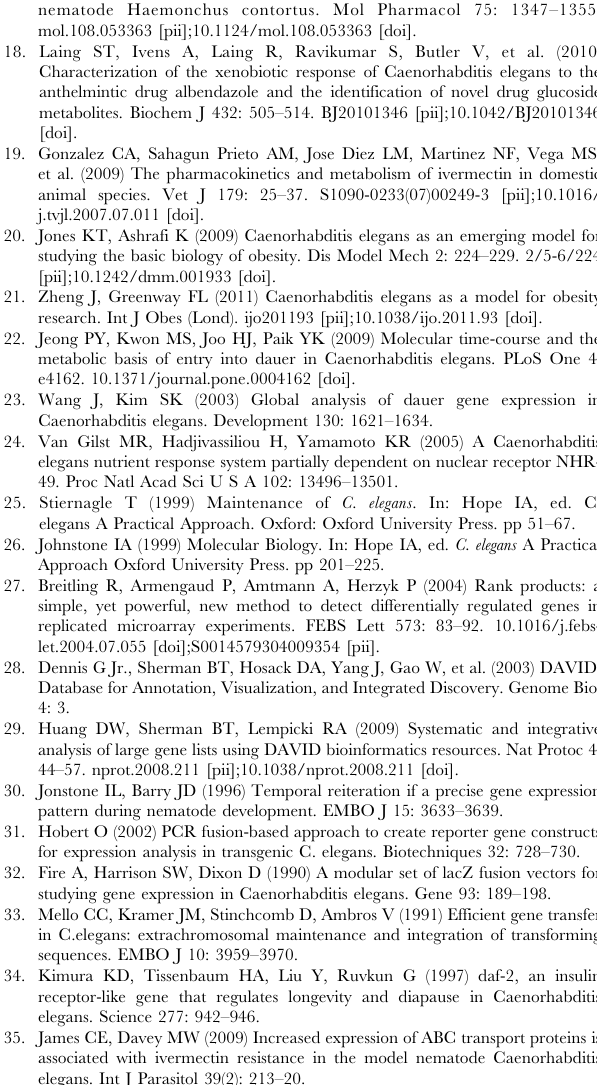
Table S1 Primer sets for real-time QPCR and GFP- fusion constructs. Table S2 Complete list of genes with significant chang- es in expression following IVM exposure. Log fold change in expression of all genes with a false discovery rate of less than 5% in both the 100 ng/ml (0.1 m M) and 1 m g/ml (1.1 m M) IVM experiments are listed.